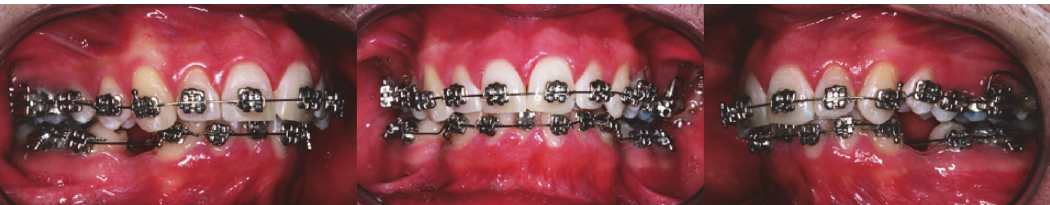
Figure 5: Extraction space before the closure.